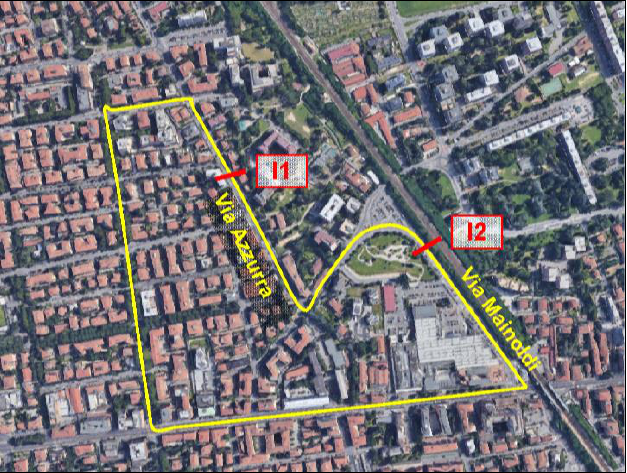
Figure 1. Outline of the experimental route. In red are the two analyzed mid-block crossings. The two mid-block crossings were characterized by white elephant feet road markings for bicycles and white zebra markings for pedestrians. The first was 0.40 m long and 0.50 m wide, while the second was 1.50 m long and 0.50 m wide. They were spaced 0.50 m from each other according to the Italian Highway Code [48] (Figure 2). These two mid-block crossings were characterized by different signaling systems: